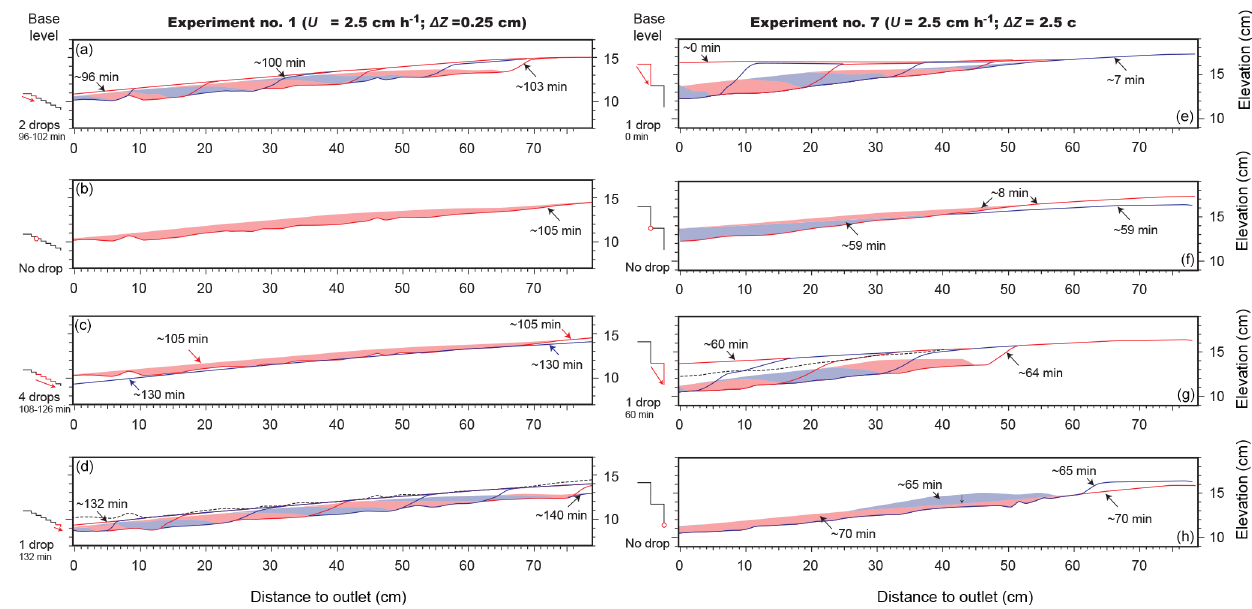
Figure 4. Evolution of two experiments with the same average rate of base-level fall ( U = 2.5cm h − 1 ), but different incremental base-level drops, (cid:49)Z . (a) – (d) For experiment 1 ( (cid:49)Z = 0.25cm), a knickpoint is propagating in between 96 and 103min (a) , leaving a alluvial layer (b) that will be progressively removed as the base level of the experiment is lowered between 105 and 130min (c) . A new knickpoint starts retreating in between 132 and 140min once the alluvium has disappeared (d) . (e) – (h) For experiment 7 ( (cid:49)Z = 2.5cm), a new knickpoint is generated each time the base level is dropped (i.e., in between 0 and 8min (e) and in between 60 and 69min (g) ). In between these drops, the profile’s slope is lowered by overall diffusion ( (f) and (h) ; see also Fig. 7b). Blue and red colored lines correspond to the successive elevation of the bedrock surface, while the light-blue and red area corresponds to the alluvium. The position of the base level is tracked on the left side of each frame. Vertical exaggeration is